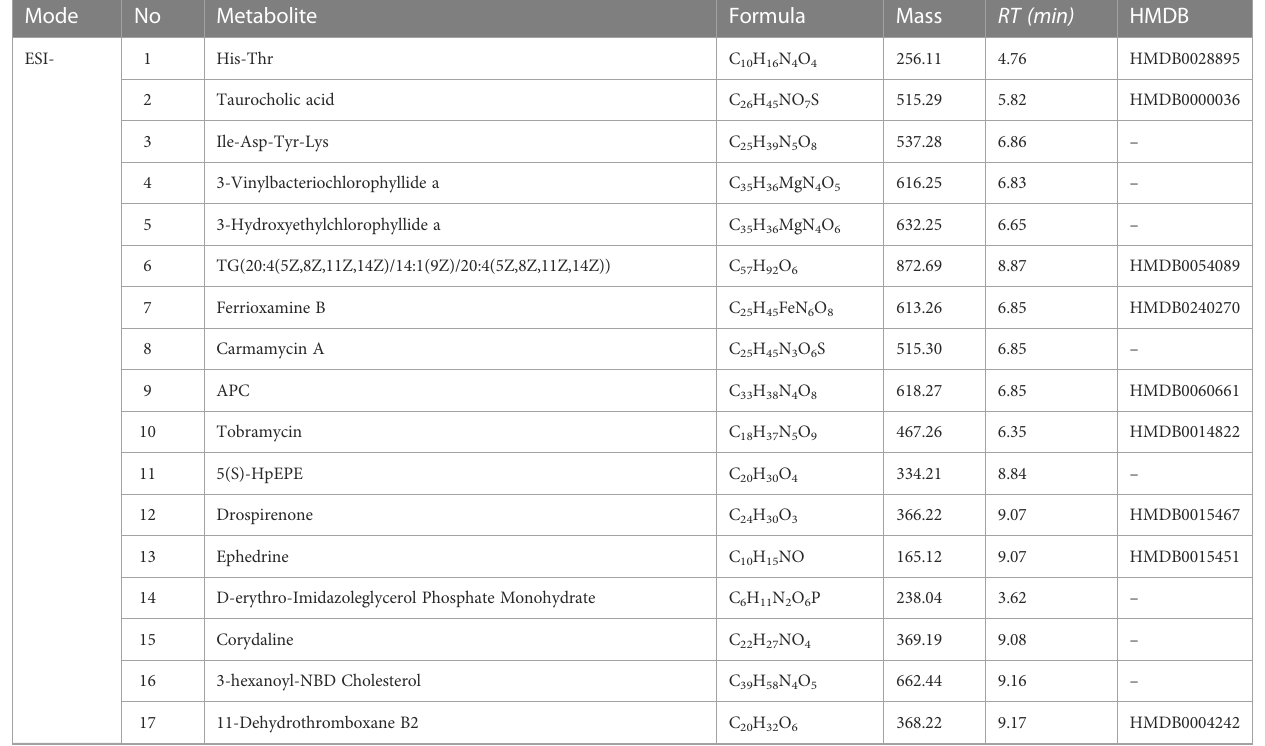
TABLE 1 List of dysregulated metabolites identi fi ed in acutely infected group in ESI − mode and ESI+ mode. Mode No Metabolite